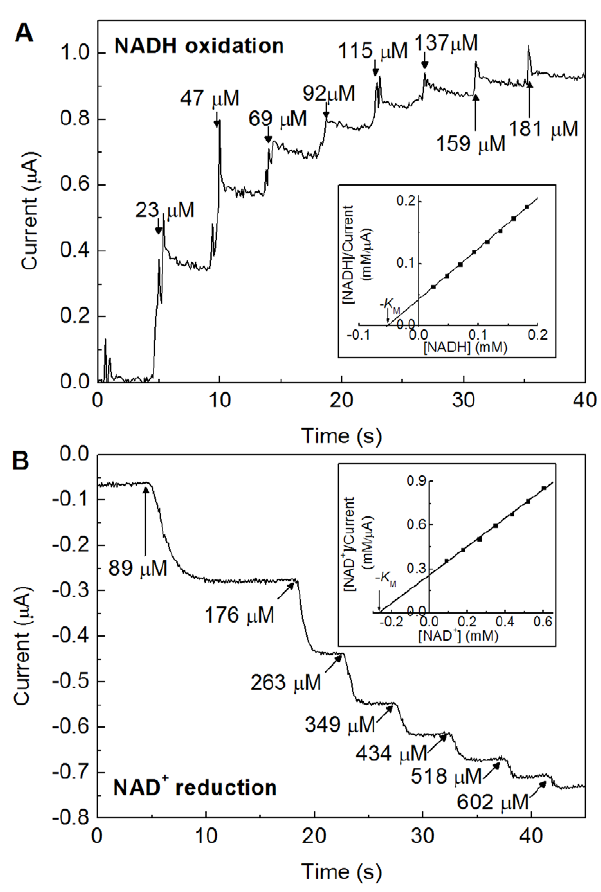
Figure 5. Electrochemical experiments designed to measure values of K M for NADH oxidation and NAD + reduction. (A) at 2 62 mV, NADH concentrations as indicated. (B) at 2 412 mV, NAD + concentrations as indicated. Other conditions: Tris-HCl buffer (50 mM, pH 8.0), 30 u C, electrode rotation rate: 2500 rpm. The inset panels show Hanes / Woolf plots for determination of K M ; current values in (B) were corrected for a non-Faradaic current offset which is evident at zero